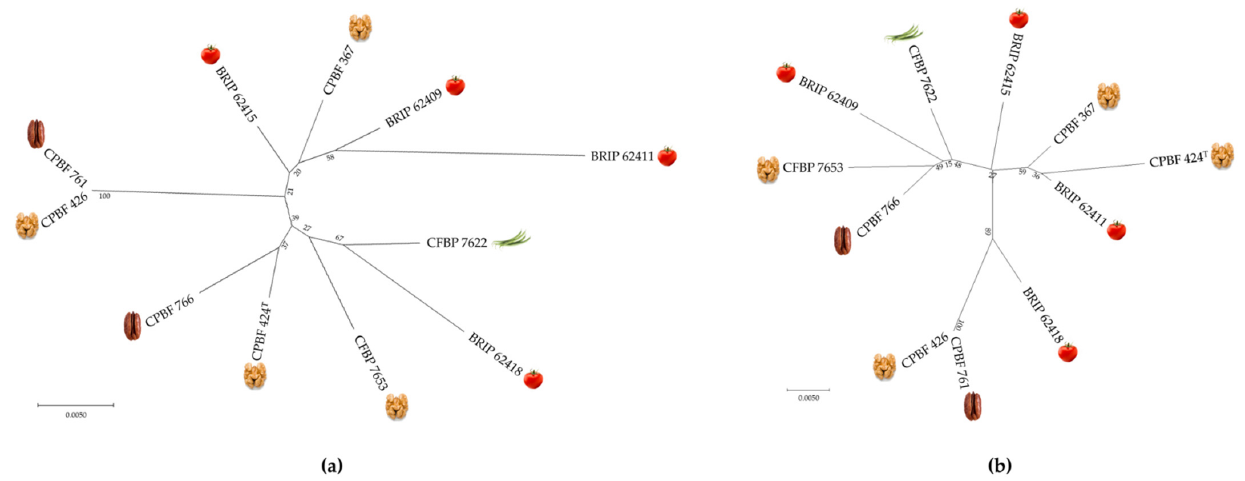
Figure 6. Maximum-likelihood phylogenetic tree based on concatenated sequences of ( a ) DNA markers XEA5, XEA6 and XEA8 (1180 bp); and ( b ) partial housekeeping gene sequences for acnB , fyuA , gyrB and rpoD (2774 bp) extracted from 11 X. euroxanthea genomes. The tree was constructed using the Tamura-Nei model using MEGA X (Kumar et al., 2018 [25]). Supporting values from 1000 bootstrap replicates are indicated near nodes.